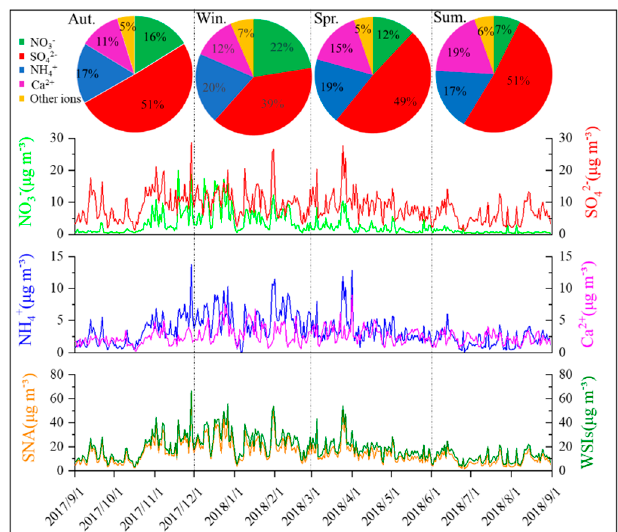
Figure 2. Seasonal changes of concentration and proportion of major ions and PM2.5 in Guiyang.